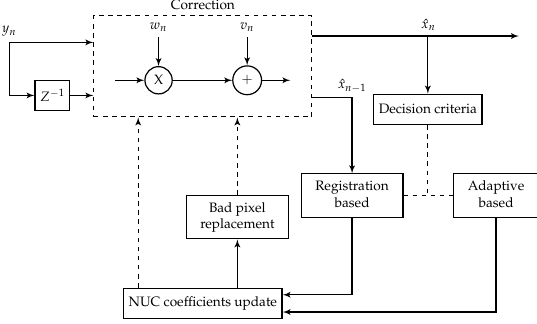
Figure 1. Scheme of the proposed